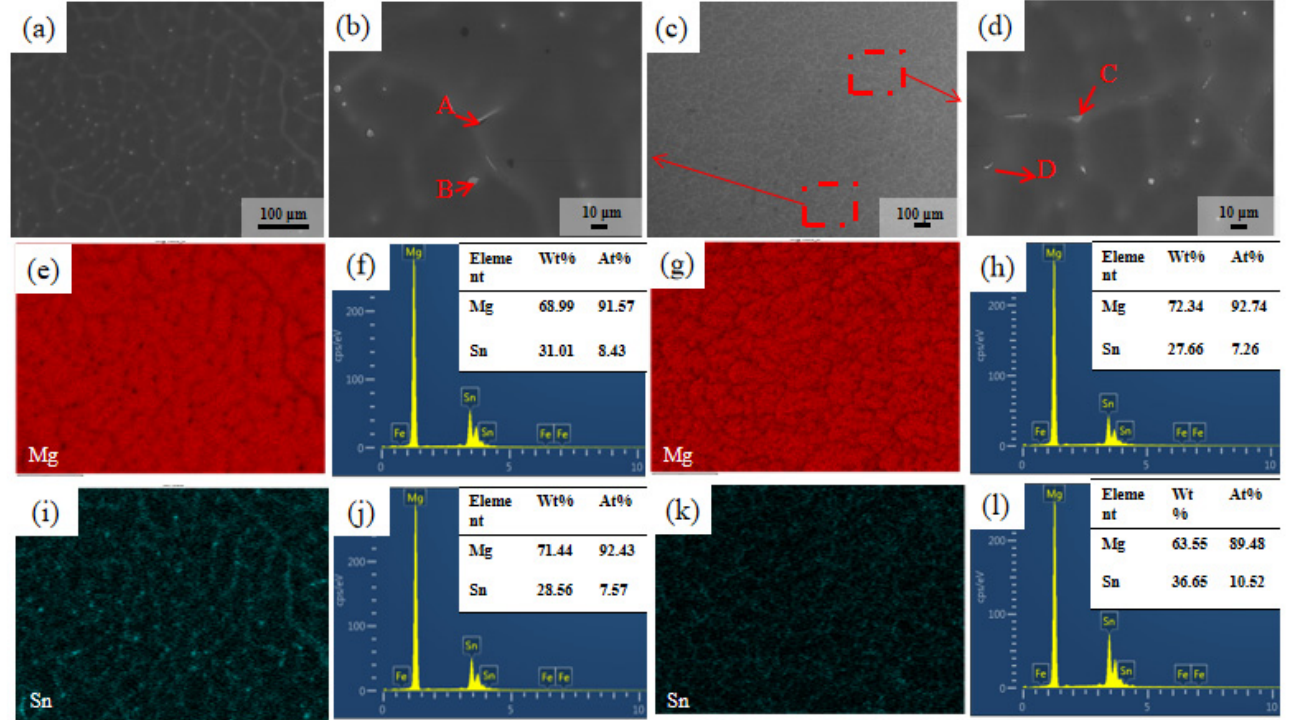
Figure 3. SEM images of ( a ) Mg-2.5Sn, ( c ) Mg-4Sn and ( b , d ) the marked region of Mg-4Sn; and